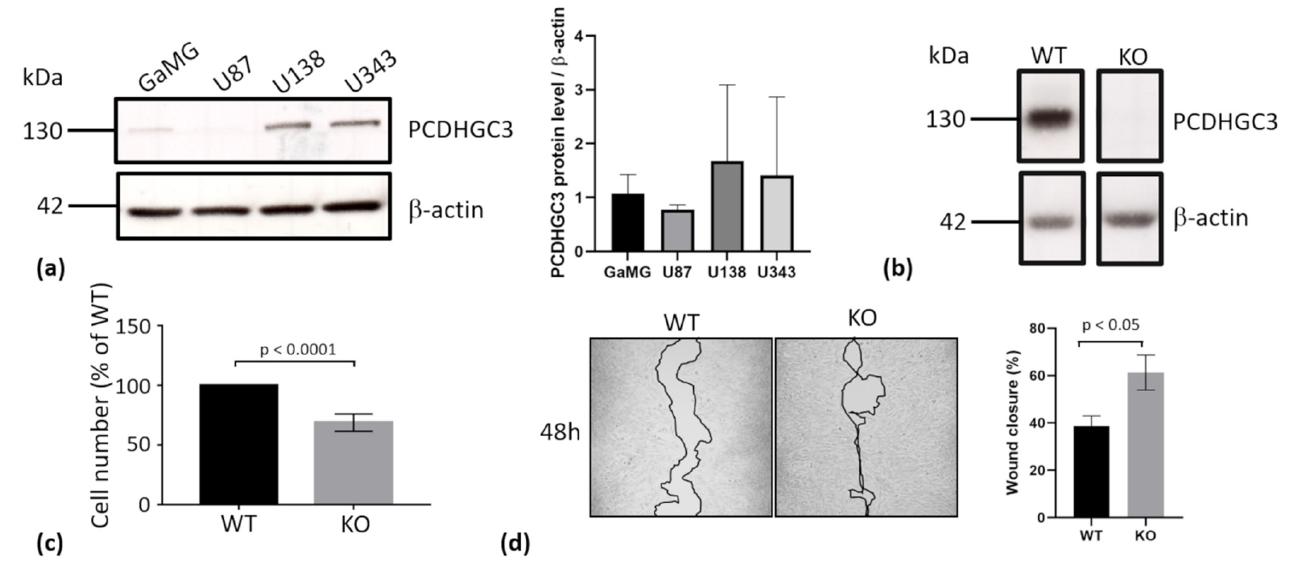
Figure 5. Deletion of PCDHGC3 in U343 cells results in a more invasive phenotype. ( a ) PCDHGC3 protein expression was determined by Western blot in glioma cell lines GaMG, U87, U138, and U343. The densitometric analysis of four passages of each cell line is shown on the right ( n = 4). ( b ) U343 was chosen to generate a PCDHGC3 knockout. The wild type (WT) expressed high levels of the PCDHGC3 protein, while PCDHGC3 knockout (KO) U343 cells displayed a complete deletion of PCDHGC3, as shown by Western blot. ( c ) Cell viability and metabolic cellular activity corresponding to cell number were measured by MTT assay and expressed as % of WT cells. ( d ) PCDHGC3 knockout (KO) U343 cells migrated faster than wild type (WT) cells in the wound healing assay (magnification 100×, cell borders are marked with a black line). The graph shows the mean percentage of wound closure at 48 h compared to 0 h and the standard deviation of three independent experiments.